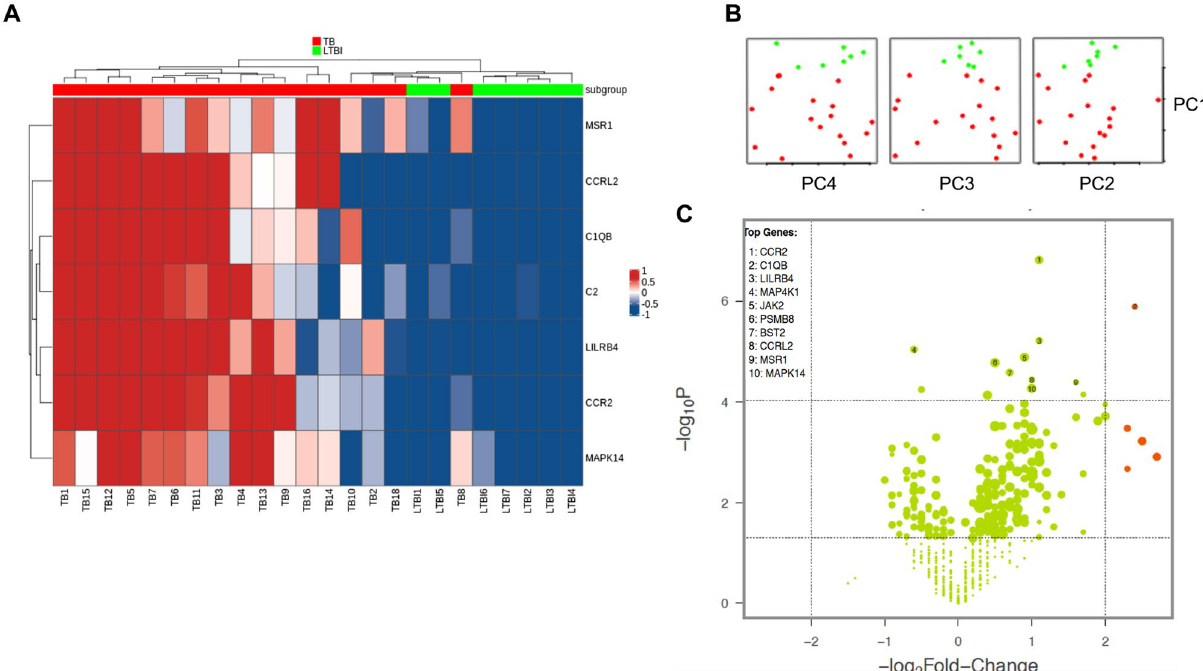
Figure 3. Identification of markers for TB progression. ( A ) Heatmap of seven gene expression levels of TB (red) and LTBI (green) subjects. ( B ) PCA score plot of TB and LTBI subjects. ( C ) Volcano plot showing the distribution of the gene expression fold changes in TB patients relative to LTBI. Genes with absolute fold change ≥ 4 and p-value ≤ 0.05 are indicated in orange. Expression levels are scaled from dark blue (low expression) to dark red (high expression). Figures were generated with R (version 3.6.3) using ComplexHeatmap package (version 2.0.0, https ://bioco nduct or.org/packa ges/relea se/bioc/html/Compl exHea tmap.html), prcomp function from stats package (version 3.6.3, https ://www.r-proje ct.org/), and NanoStringNorm package (version 1.2.1.1, https ://cran.r-proje ct.org/web/packa ges/NanoS tring Norm/index .html) for heatmap, pca and Volcano plot,